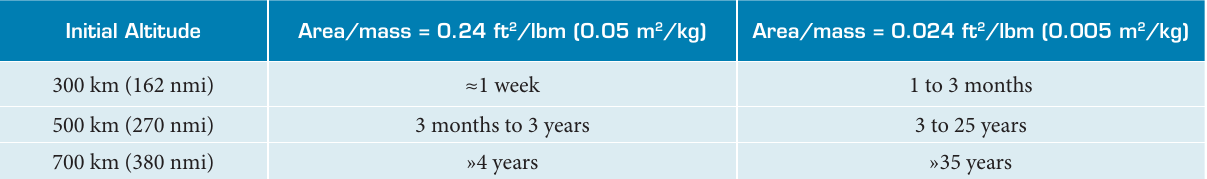
Table 6. Estimates of the range of orbital lifetimes for high and low values of solar activity (assumed constant), illustrating the magnitude and the great variability of orbital lifetimes.